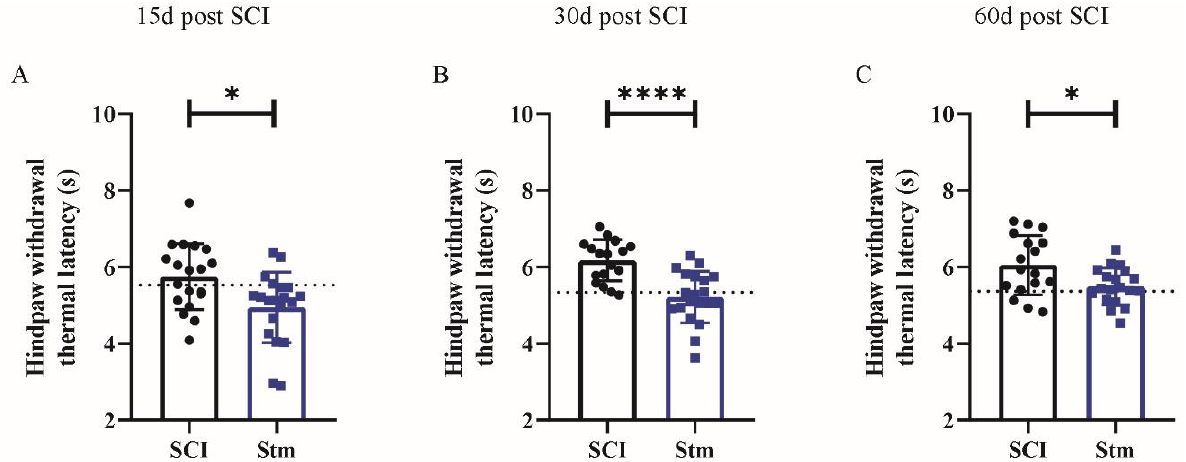
Figure 5. rTSMS treatment modulate sensitive recovery after SCI in rats. Quantification of hindpaw withdrawal thermal latency at ( A ) 15 days, ( B ) 30 days and ( C ) 60 days after SCI. Quantifications are expressed as average ± SD; n = 19 animals per SCI group and n = 20 animals per STM group at 15 days, n = 18 animals per SCI group and n = 20 animals per STM group at 30 days and n = 17 animals per SCI group and n = 19 animals per Stm group 60 days after SCI. Dashed lines correspond to the baseline parameters obtained with non-injured animals. Statistical evaluations were based on the Mann–Whitney test (* = p < 0.05 and **** = p < 0.0001).